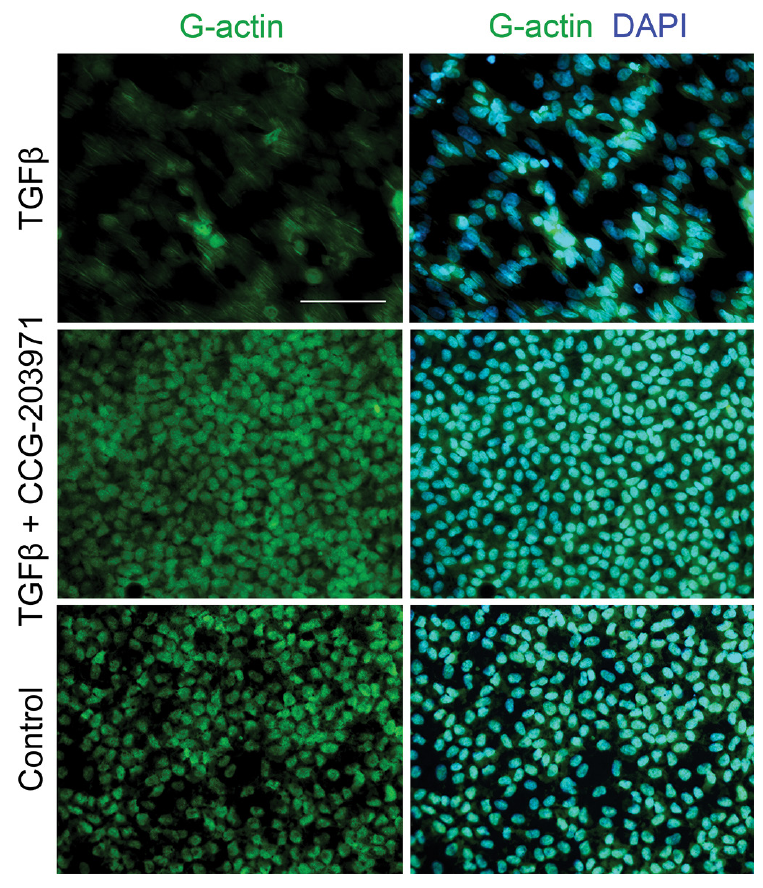
Figure 5. CCG-203971 prevents TGF β -induced nuclear G-actin depletion. Lens explants were treated with TGF β (4 ng/mL) in the presence and absence of CCG-203971 (5 μ M). After 48 h, explants were fixed and stained with DNase I, which selectively binds G-actin monomers, then mounted in medium with DAPI to colocalize nuclei. Scale bar = 100 μ